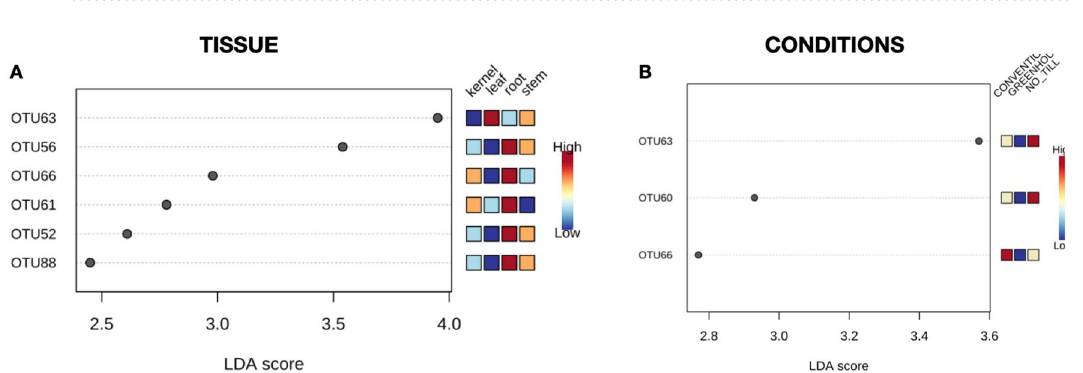
Figure 3. PCoA based on weighted UniFrac of the endogenous fungal communities’ structure in diverse wheat ( a ) cultivars, ( b ) conditions, and ( c ) forms depending on wheat tissue.